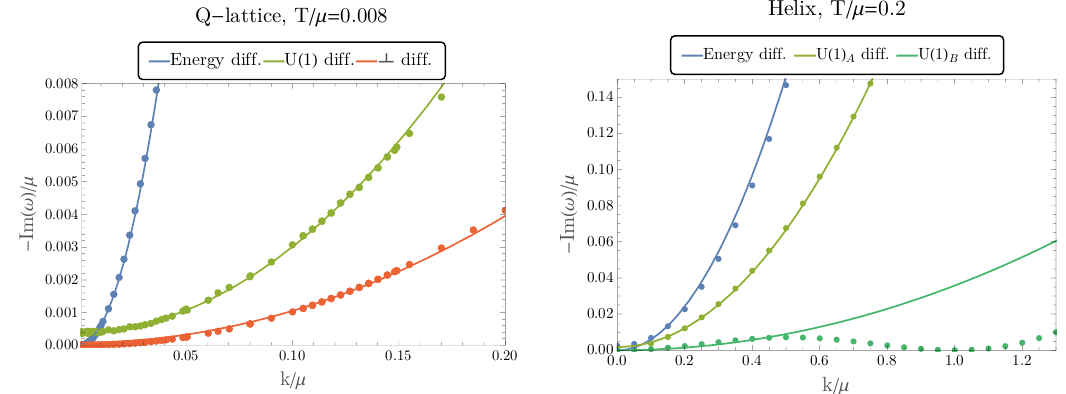
Figure 9. Parabolic dispersion (cid:12)ts of di(cid:11)usive modes at low temperature. The di(cid:11)usive modes in both theories are governed by the quadratic dispersion at low k , even though the applicability of the hydrodynamics is not guaranteed in this low-T regime due to strong momentum